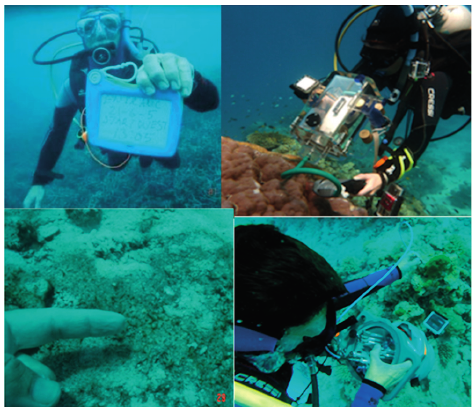
Figure 1. Underwater field spectroscopy. Documenting metadata underwater ( upper left ), photo of target feature with finger pointing the exact target area ( lower left ), JAZ ocean optic spectrometer in off the shelve housing ( lower right ), ASD field spec 2 build in customized underwater housing ( upper right ). Source: